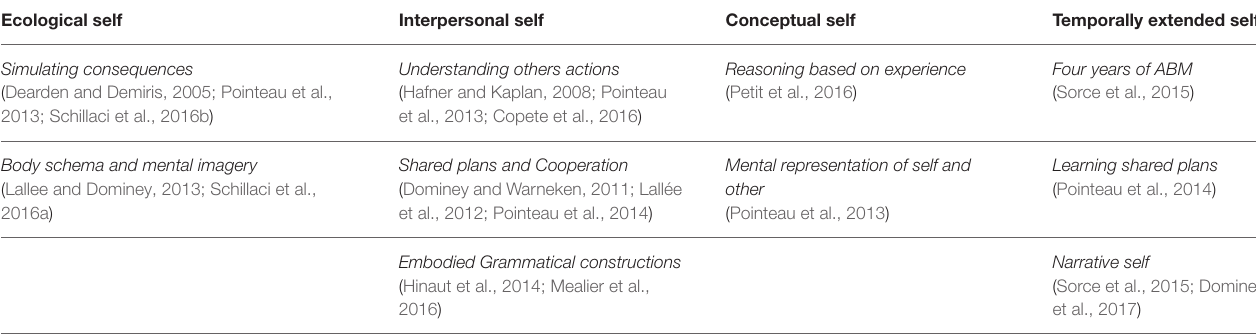
TABLE 5 | Summary of cognitive functions developed in the iCub and other robot systems, mapped onto Neisser’s four dimensions of self. Ecological self Interpersonal